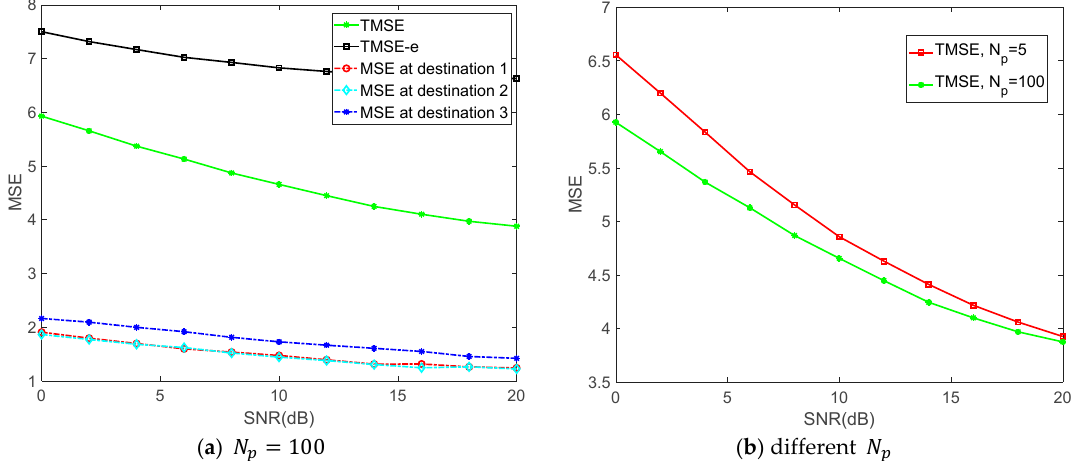
Figure 3. The TMSE and MSE versus signal to noise ratio (SNR).